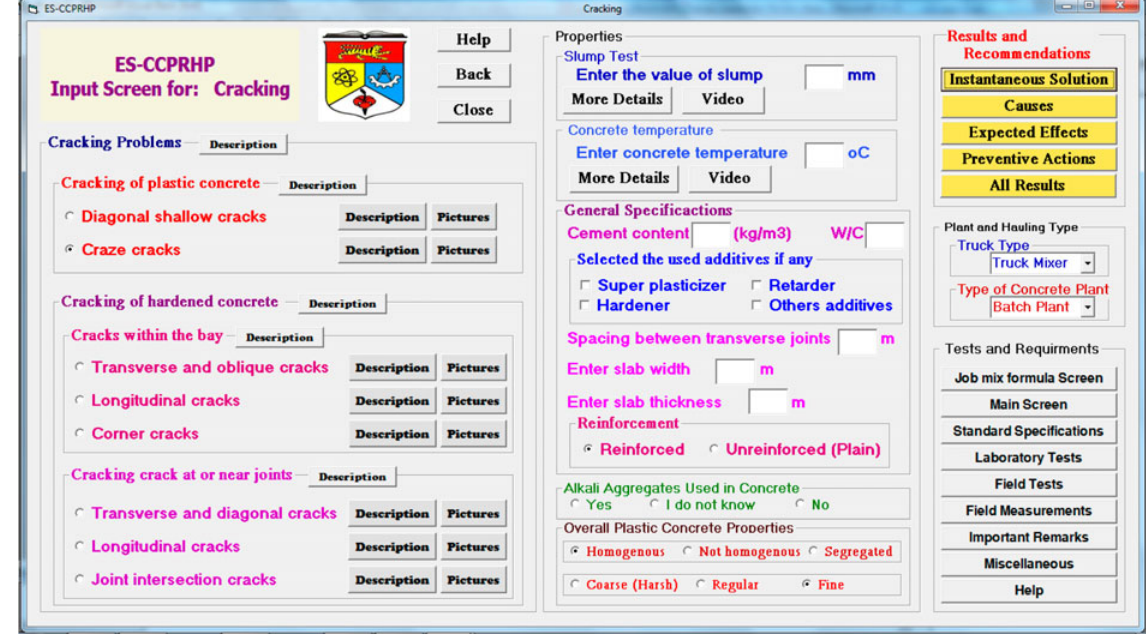
Fig. 3. ES-CCPRHP cracking input